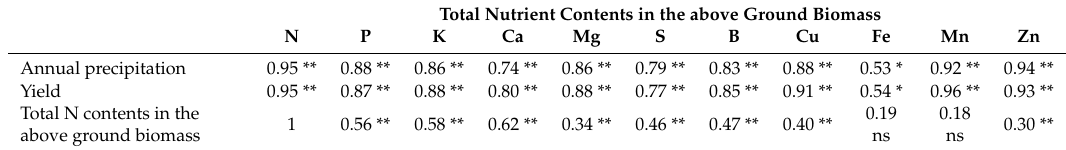
Table 9. Pearson’s correlation coe ffi cients ( r ) between the total nutrient contents in the above ground biomass of Mchare banana plant at harvest and (i) annual precipitation, (ii) yield, and (iii) total N